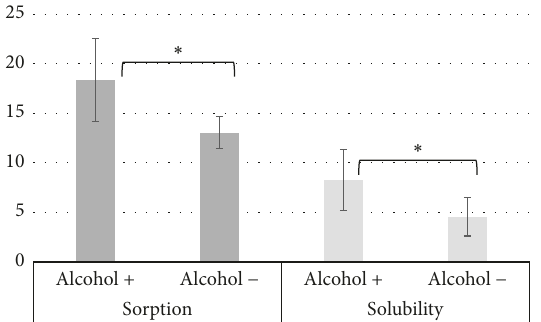
Figure 1: Sorption and solubility (mean ± SD, 𝜇 g/mm 3 ) of compos- ite resins in the mouthwashes according to the presence or absence of alcohol ( 𝑛 = 36 ). The asterisk indicates a significant difference ( 𝑝 < 0.05